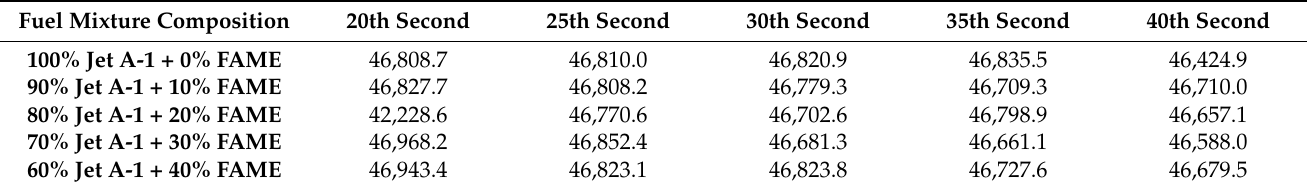
Figure 15. The graphic course of SJE-20 n [min − 1 ] speed changes when using different mixtures of Jet A-1 aviation kerosene and FAME biofuel. Table 20. Change in revolutions n [min − 1 ] with different concentrations of Jet A-1 aviation kerosene and FAME biofuel.